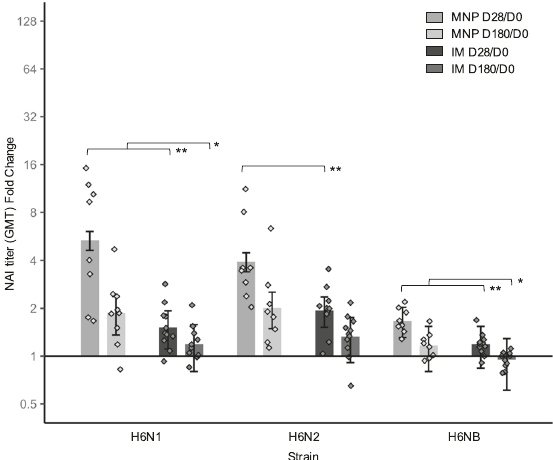
Fig. 2 Fold change of neuraminidase inhibition (NAI) geometric mean titers (GMT) (log2) over baseline level at Day 28 and Day 180 following vaccination. Testing was performed against H6N1, H6N2, and H6NB strains for MNP ( n = 8) and IM ( n = 11) groups with geometric standard error (vertical bars). Black lines indicate statistical signi fi cance based on Wilcoxon rank-sum test. * P < 0.05; ** P < 0.01. IM, IIV by intramuscular route; MNP, IIV by microneedle patch; D, Day.